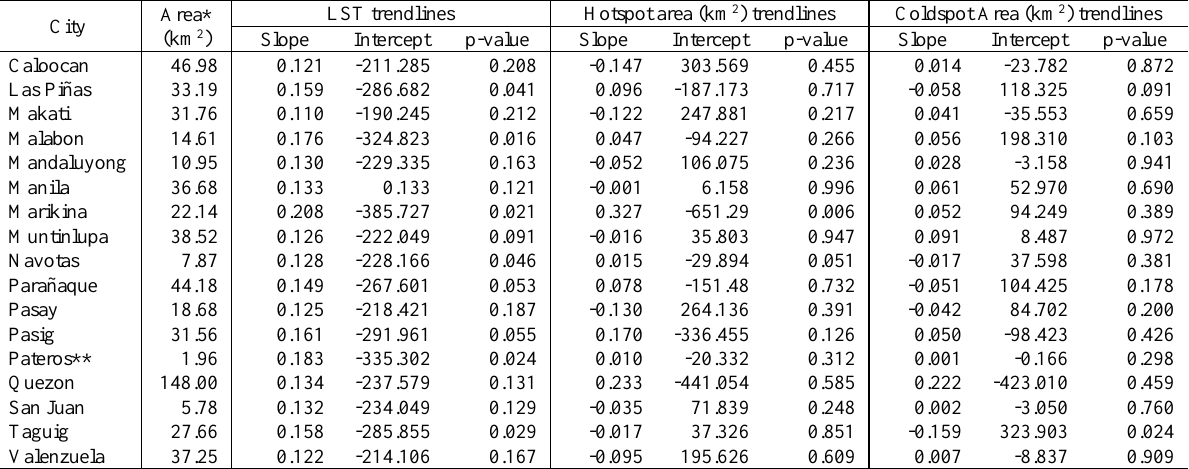
Table 2. Table summary of linear trendlines (slope, intercept, and p-value of the line) for each LST, hotspot area, and coldspot area time-series plots per city in Metro